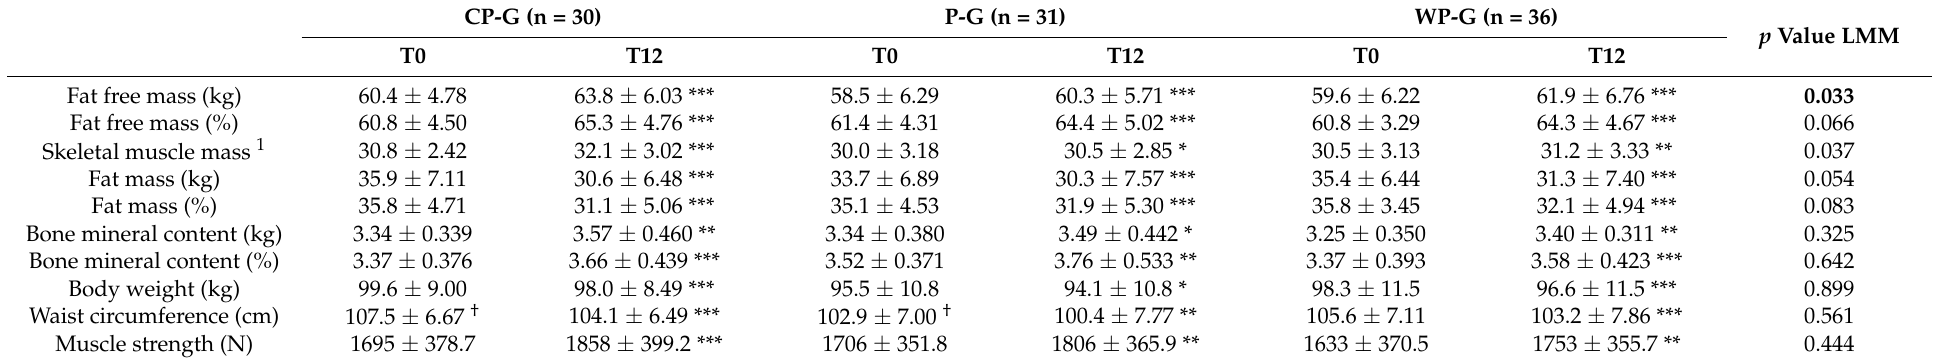
Table 3. Efficacy outcomes at baseline and following supplementation with collagen peptides, whey protein or